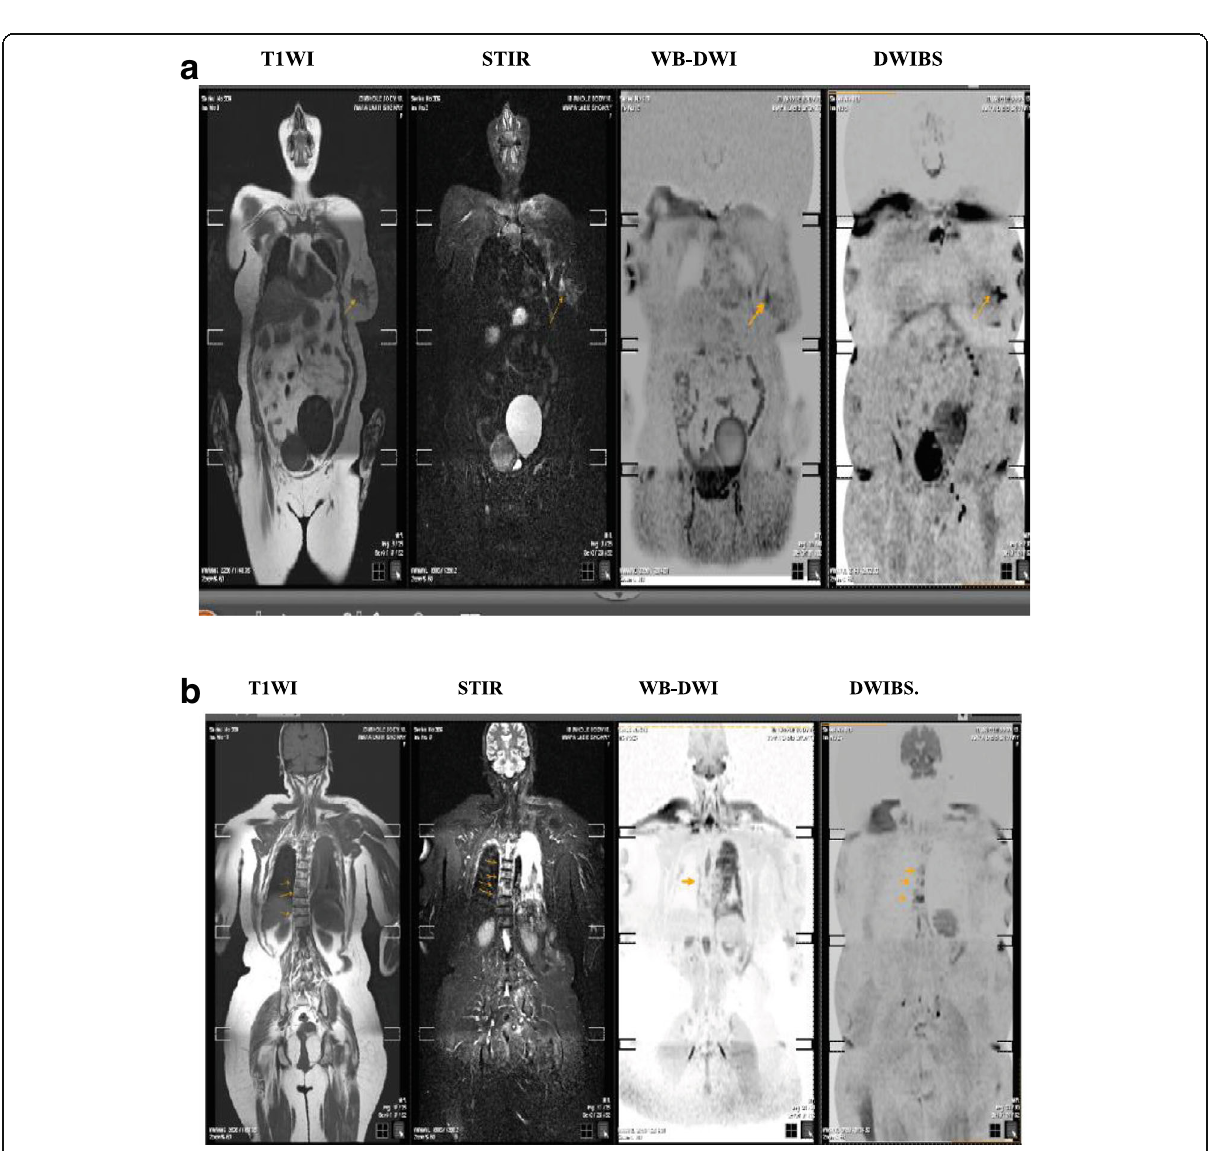
Fig. 1 A 48-year-old female diagnosed as invasive duct carcinoma GII left breast. a Lt. breast lesion seen in A coronal T1WI, B coronal STIR, and D DWIBS but not seen in C WB-DWI. b Multiple thoracic vertebral deposits seen at a coronal T1WI, B coronal STIR, C WB-DWI, and D DWIBS. DWIBS detected the left breast lesion more obviously than T1WI and STIR, and detected multiple osseous deposits even more than